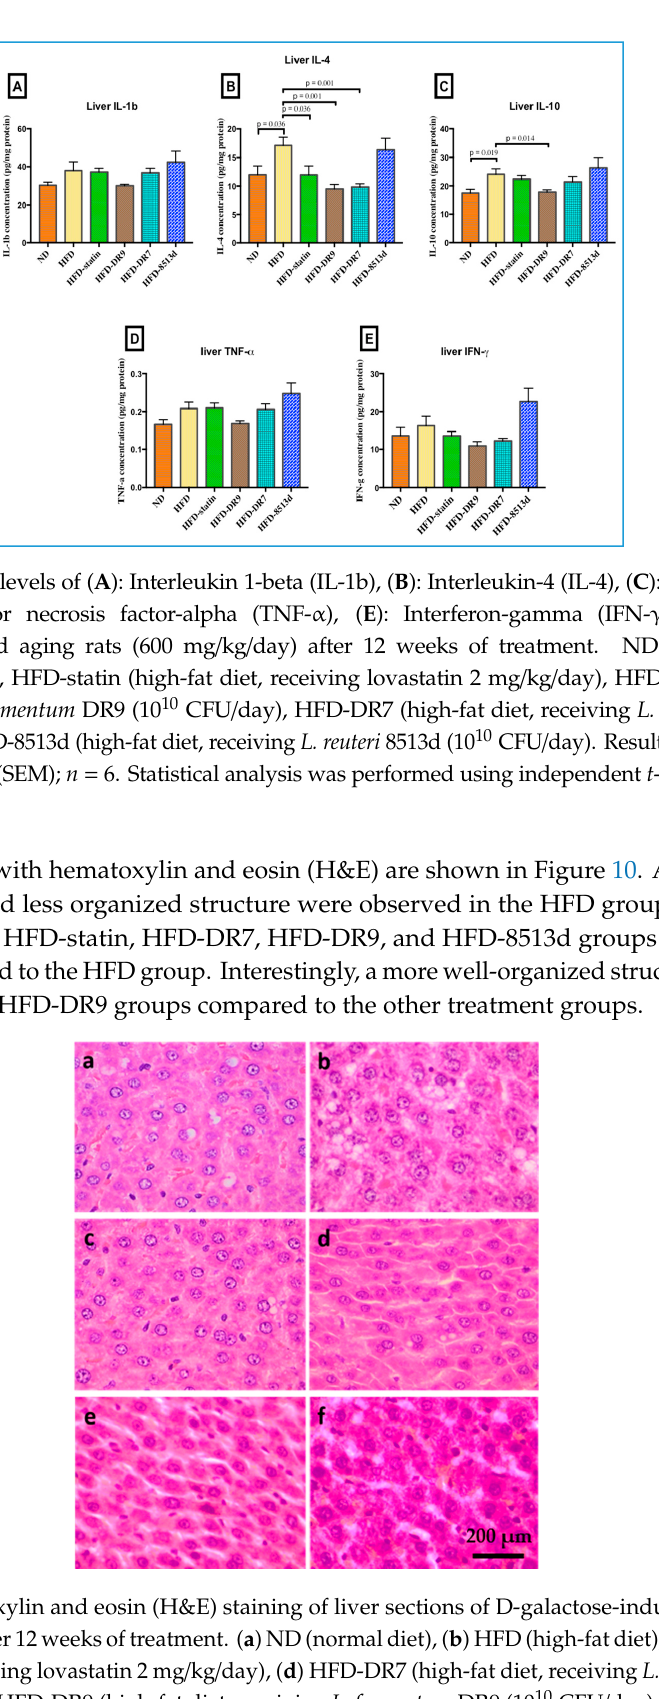
9 of 18 Figure 8. Relative gene expression of ( A ) AMPK α 1 ( B ) AMPK α 2 in liver of D-galactose-induced aging rats (600 mg/kg/day) after 12 weeks of treatment. ND (normal diet), HFD (high-fat diet), HFD-statin (high-fat diet, receiving lovastatin 2 mg/kg/day), HFD-DR9 (high-fat diet, receiving L. fermentum DR9 (10 10 CFU/day), HFD-DR7 (high-fat diet, receiving L. plantarum DR7 (10 10 CFU/day), HFD-8513d (high-fat diet, receiving L. reuteri 8513d (10 10 CFU/day). Results are expressed as mean; error bars (SEM); n = 6. Statistical analysis was performed using independent t -tests. 2.4. Liver Immune Response: IL-1 β , IL-4, IL-10, TNF- α , and IFN- γ Protein expression (Interleukin-1beta (IL-1 β ), Interleukin-4 (IL-4), Interleukin-10 (IL-10), Tumor necrosis factor alpha (TNF- α ), Interferon gamma (IFN- γ )) in liver tissue after 12 weeks of treatment